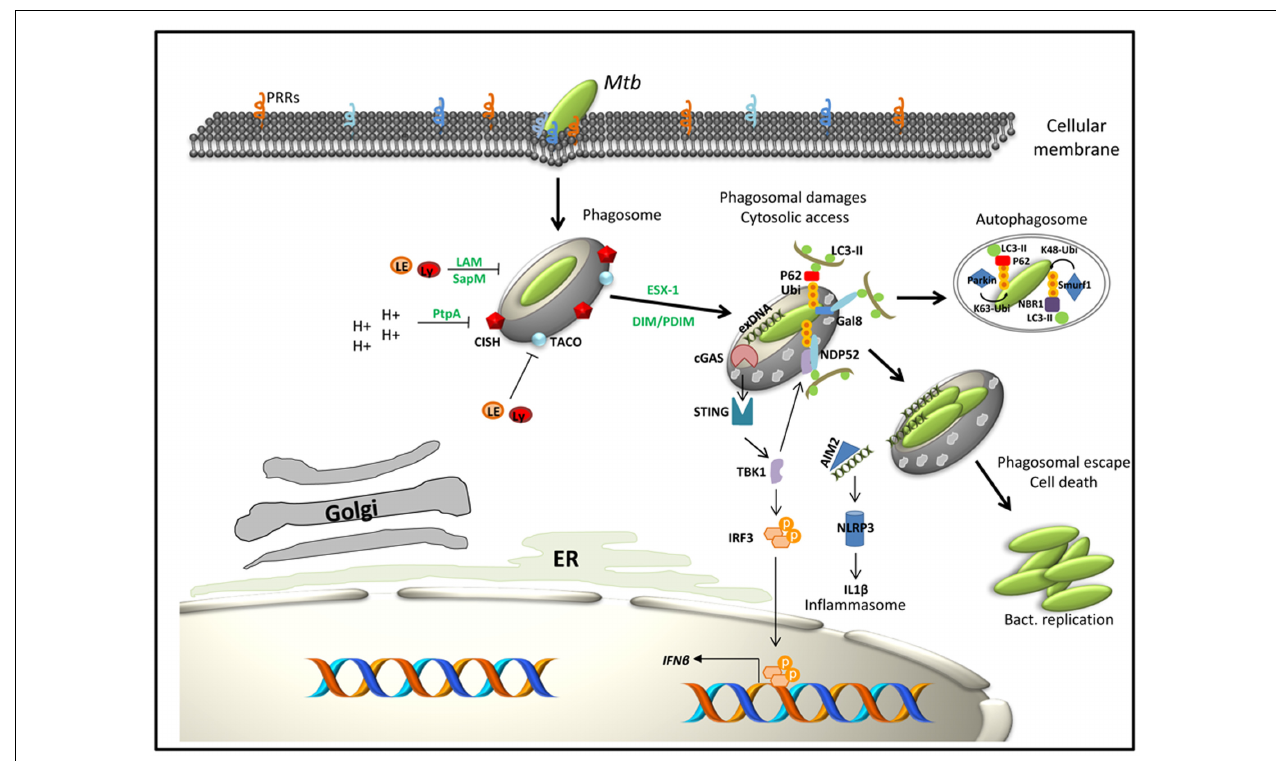
FIGURE 1 | Working model for selected components intervening in the immune subversion strategies of Mtb as well as macrophage factors that contribute to host defense. In green: bacterial factors; in black: macrophage factors. Interaction of Mtb with macrophage PRRs triggers bacteria internalization. The first strategy of Mtb to conquer macrophages is to inhibit phagosome maturation and acidification through the expression or secretion of bacterial factors (LAM, SapM, PtpA) or by subverting host pathways such as TACO or CISH signaling. Bacteria then progressively access to the cytosol through the action of the ESX-1 secretion system and DIM/PDIM. When in contact with the cytosol, bacteria get targeted by ubiquitin ligases (Parkin, Smurf1) and/or activate specific cytosolic recognition pathways (gal8, cGAS, or AIM2). This latter step induces expression of type I IFN, activation of the NRLP3 inflammasome and initiation of autophagy. Lastly, cytosolic Mtb induces host cell death programs (apoptosis and necrosis) to enhance its